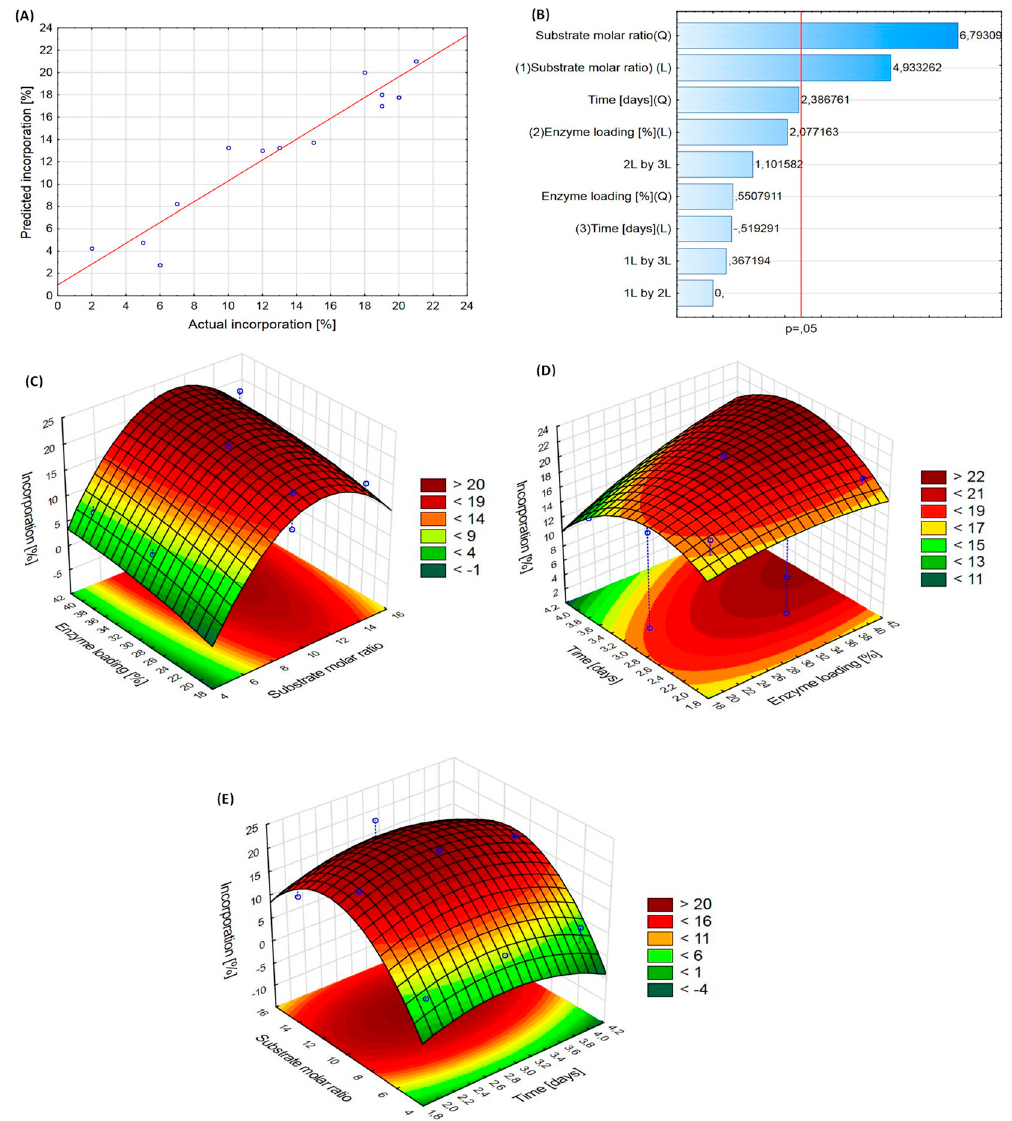
Figure 2. ( A ) Correlation of actual and predicted values of incorporation of 3,4DMCA into phospholipids (PLs) by the response surface model, ( B ) Pareto chart of the analyzed effects for incorporation of 3,4DMCA into PLs, Response surface plot showing effect of ( C ) enzyme loading and substrate molar ratio ( D ) time of reaction and enzyme loading and ( E ) substrate molar ratio and time of reaction on the incorporation of 3,4DMCA into PLs.